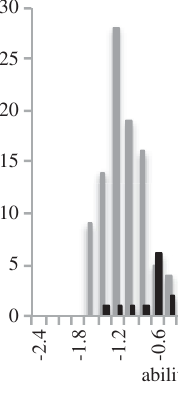
FIG. 14. The pre- and postability histograms for class